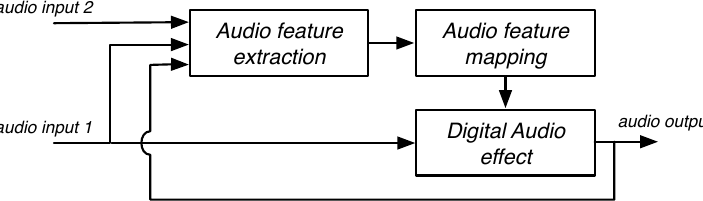
Figure 8. Diagram of an adaptive digital audio effect: The control parameters are derived from audio features extracted from an input signal. The features may be extracted from the signal that is to be transformed (input 1), from a different input signal (input 2), or from the effect